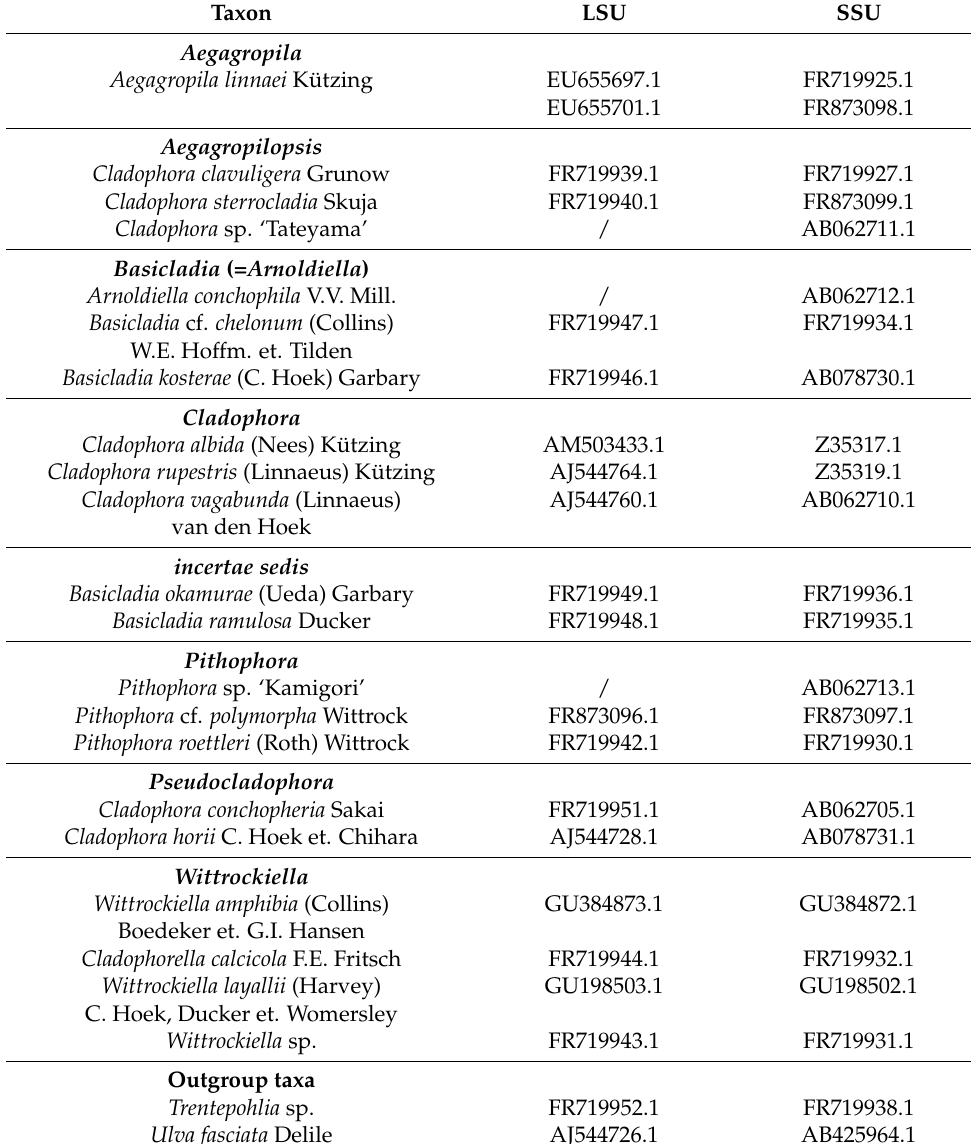
Table 1. GenBank accession numbers of sequences used from previously published taxa under the appropriate tree clades (modified from [17]) / = no